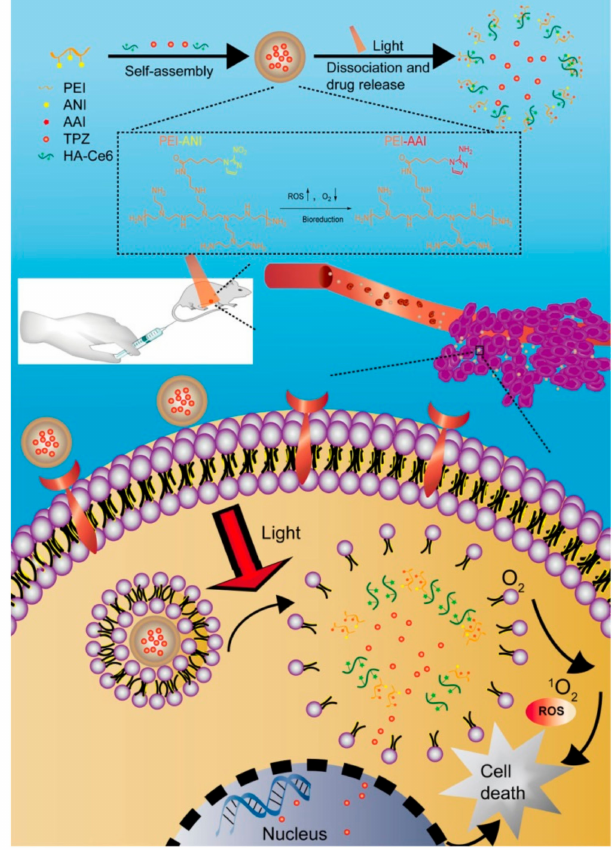
Figure 3. Schematic representation of the dual hypoxia-responsive amphiphilic polyethyleneimine − alkyl nitroimidazole (PA)/hyaluronic acid-chlorin e6 tirapazamine (HA-Ce6@TPZ) nanoparticles toward photo- dynamic therapy (PDT)-strengthened bioreductive therapy. Source: reprinted with permission from [75]. Copyright (2019) American Chemical